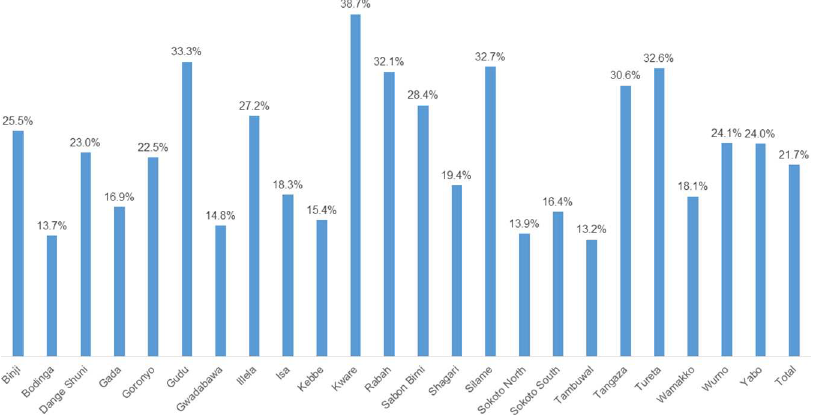
Fig 7. Percentage of mothers that receivedmisoprostol in each Local Government Area(LGA) between April 2013 and Decemberof